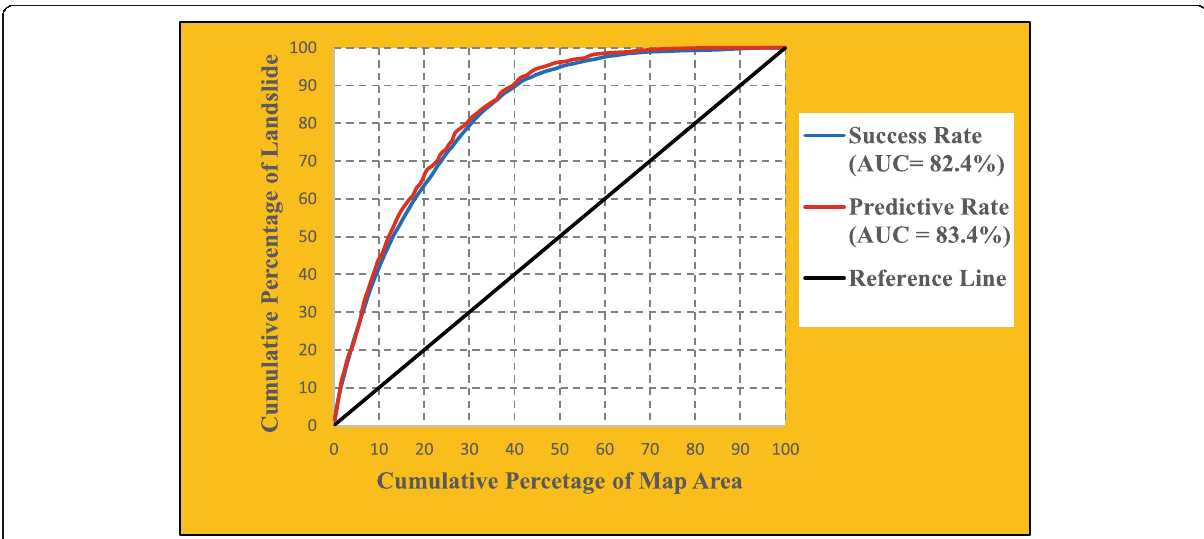
Fig. 9 Success rate and predictive rate curves for weights of evidence